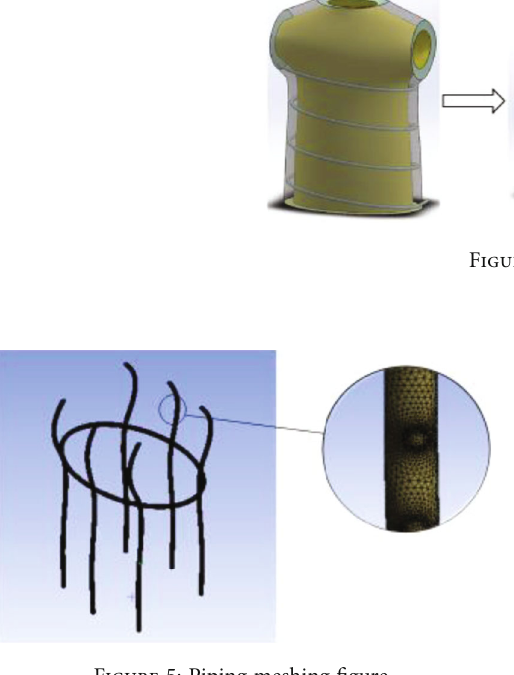
Figure 5: Piping meshing fi